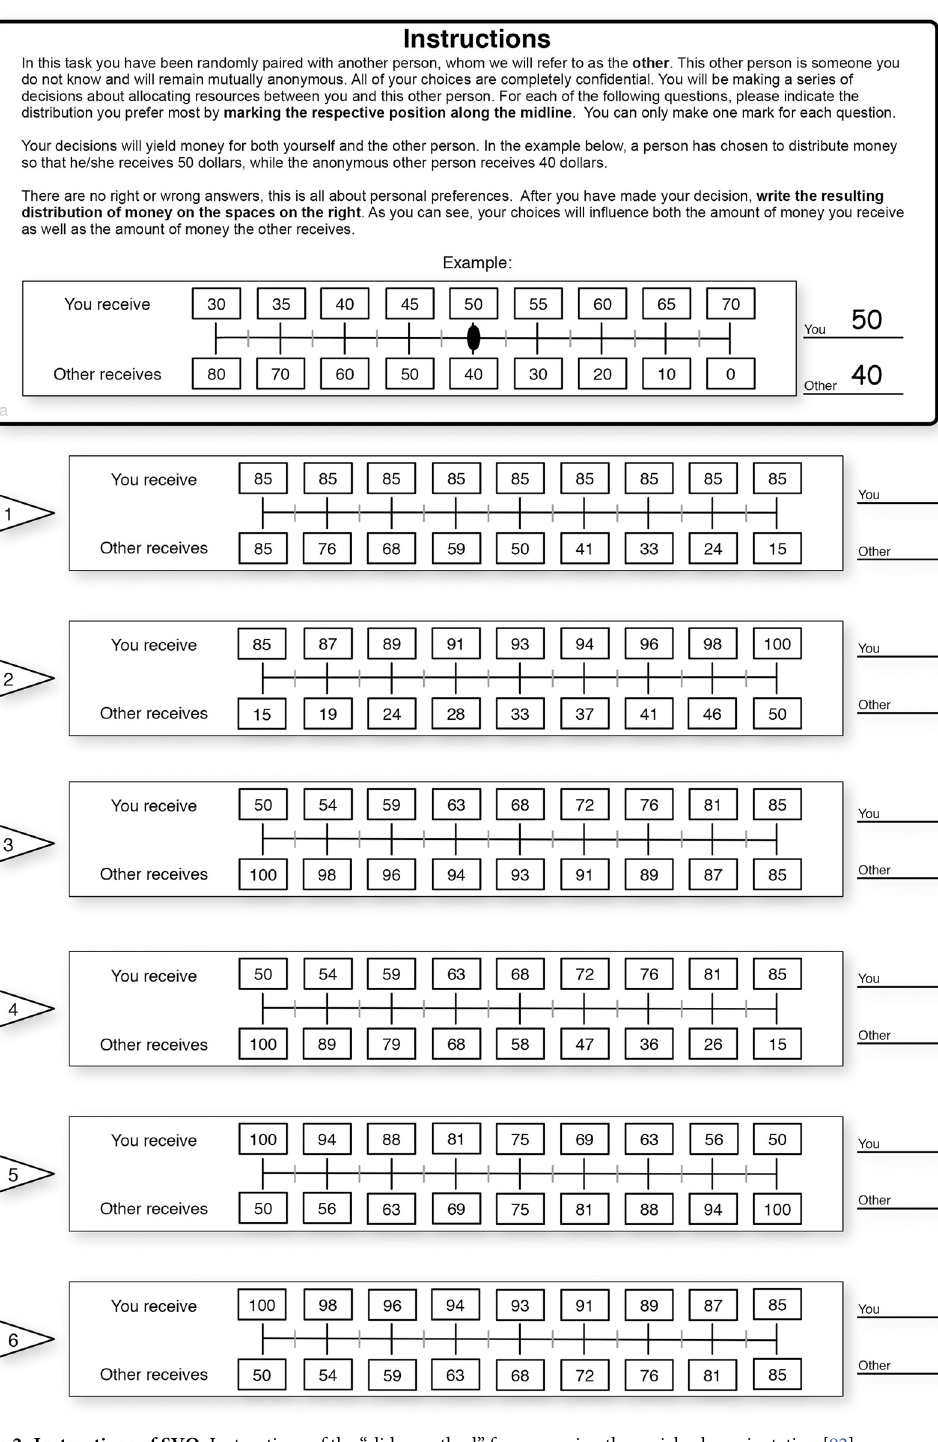
PLOS ONE | https://doi.org/10.1371/journal.pone.0264222 February 25,